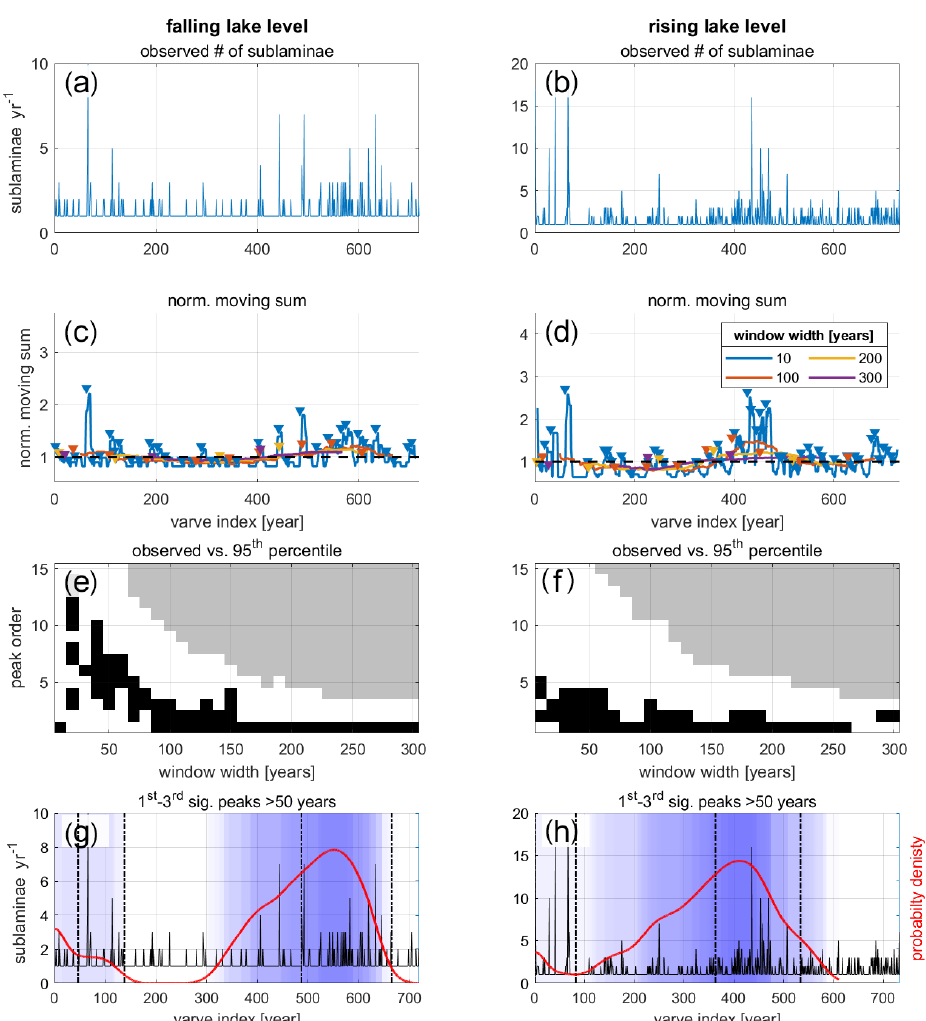
Figure 3. Results of the non-parametric test developed for identifying flood-rich episodes (i.e., flood clustering). (a, b) The studied series of flood frequency analysed using microfacies analyses of two DSDDP core sections. (c, d) The running normalized sum calculated for identifying flood clusters and their peaks (triangle) using different window widths. (e, f) Binary diagrams indicating where observed y w ( i ) values are higher than the calculated 95th percentile of the distributions derived from 10000 randomly permutated series and are thus statistically significant considering α = 0.05 (black pixels) or non-significant (white pixels). Missing values, where not enough peaks were detected to calculate the 95th percentile, are coloured grey. (g, h) The location of statistically significant peaks at α = 0.05 depicted as semi- transparent shading for the top three highly ranked peaks of window widths ranging between 50 and 300 superimposed on the data series. The red line depicts the probability of the summed identification of clusters by all window widths. The refined clusters are marked by dashed vertical